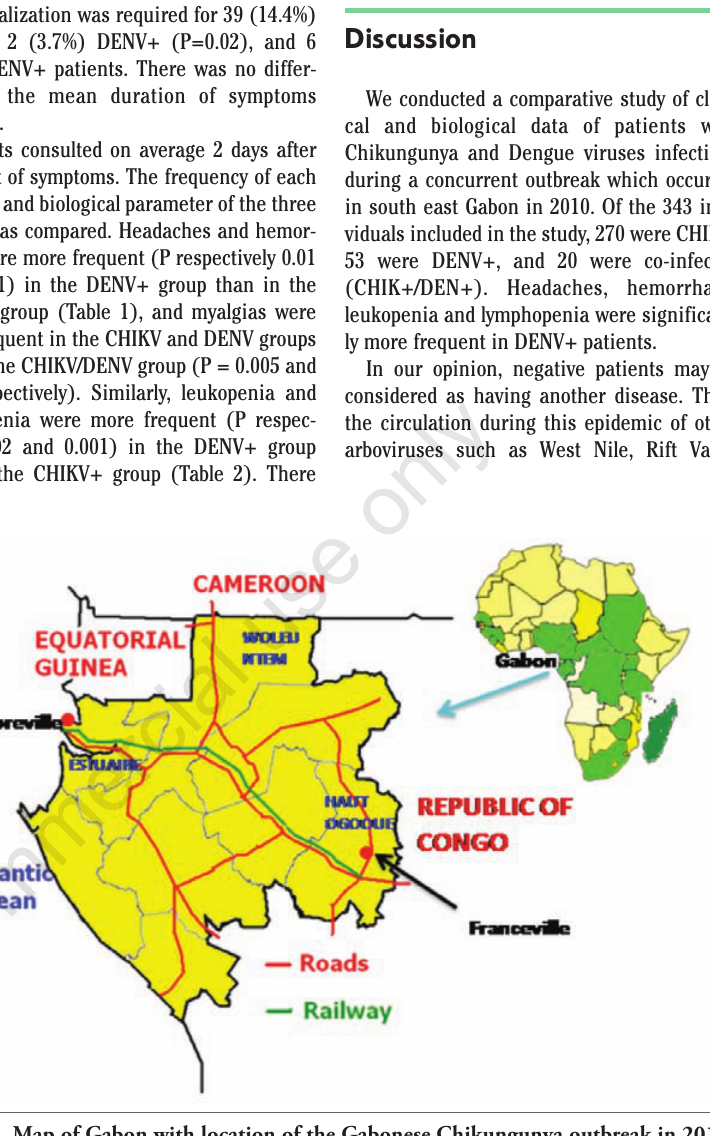
Figure 1. Map of Gabon with location of the Gabonese Chikungunya outbreak in 2010. Table 1. Comparison of clinical signs between Chikungunya and Dengue-infected patients during the 2010 outbreak in Gabon.